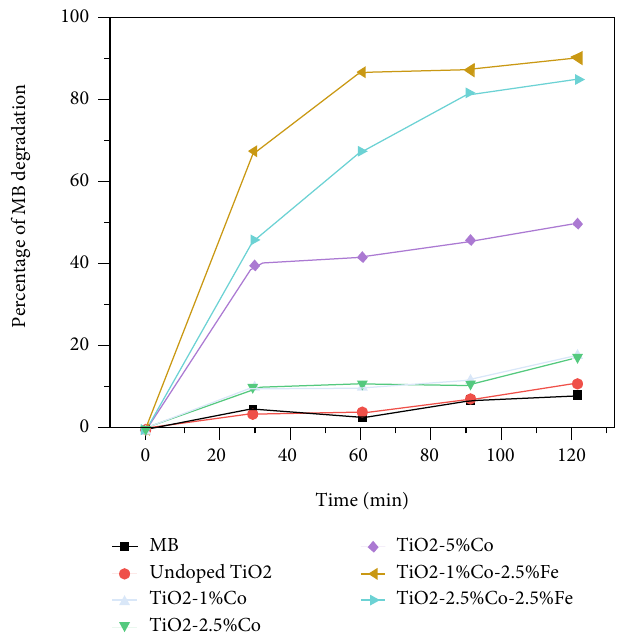
Figure 7: The degradation of MB using di ff erent catalysts: undoped TiO TiO -2.5%Co-2.5%Fe samples under visible light irradiation. 2